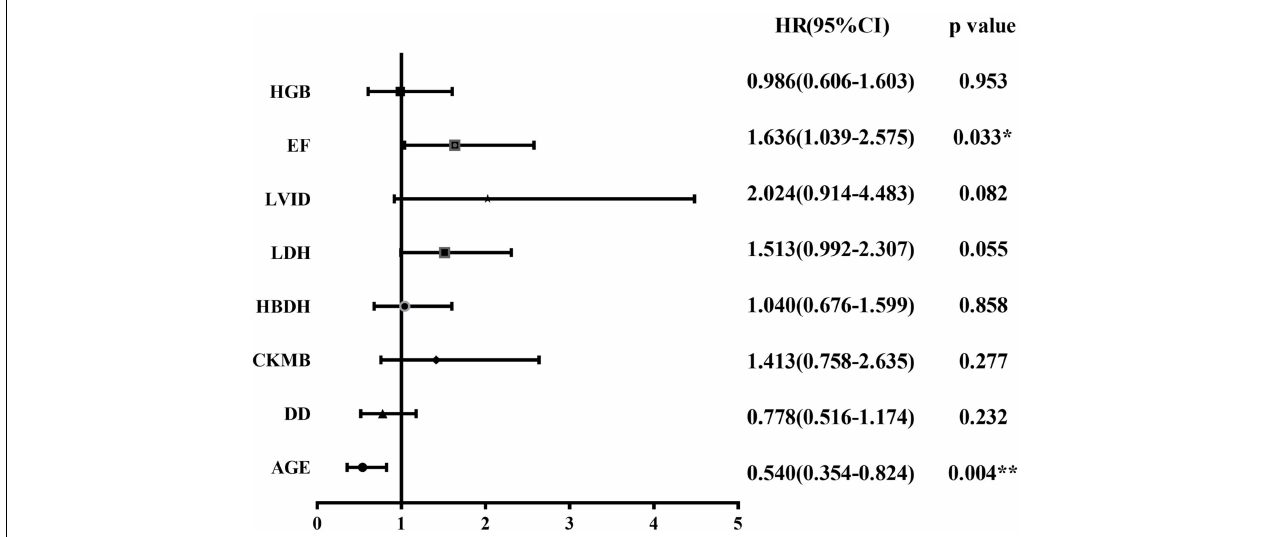
FIGURE 5 | Forest plot for Cox regression analysis. Cox regression model for multivariate analysis. * p < 0.05, ** p < 0.01. HRs and 95% CIs are estimated in Cox proportional hazards regression. CI, confidence interval; CK-MB, creatine kinase myocardial band; DD, D-dimer; EF, ejection fraction; HBDH, hydroxybutyrate dehydrogenase; HGB, hemoglobin; HRs, hazard ratios; LDH, lactate dehydrogenase; LVID, left ventricular internal diameter.